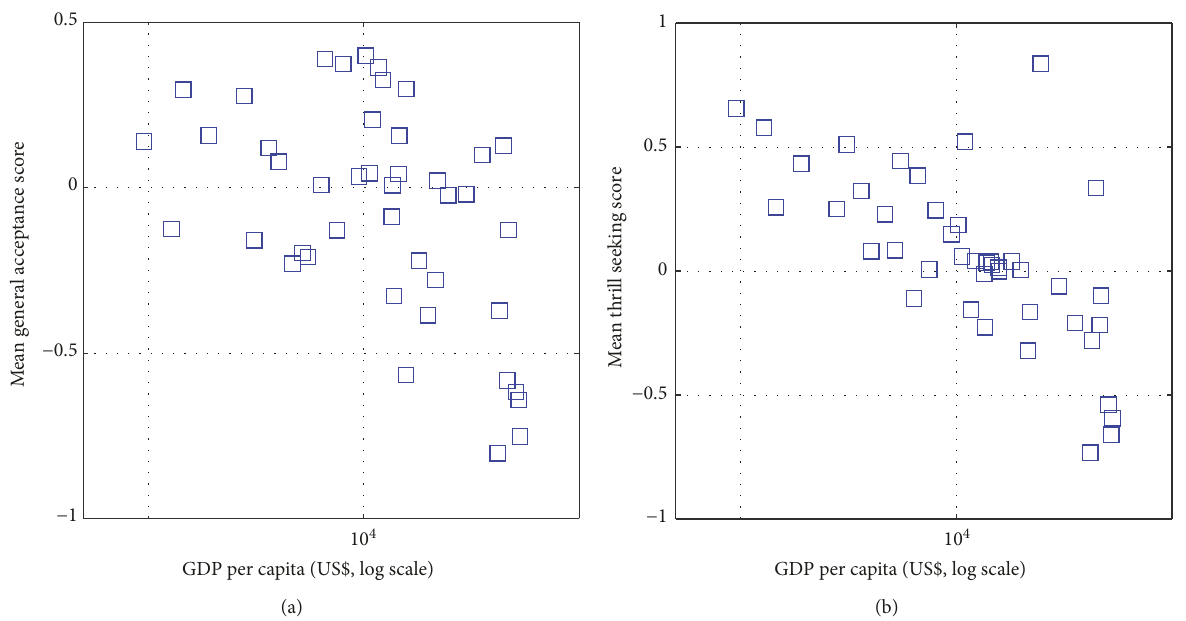
Figure 3: Correlation between countries’ gross domestic product (GDP) per capita and participants’ mean general acceptance score (a) and participants’ mean thrill seeking score (b). Each marker represents a country with 25 or more respondents ( 𝑛 = 43 ).